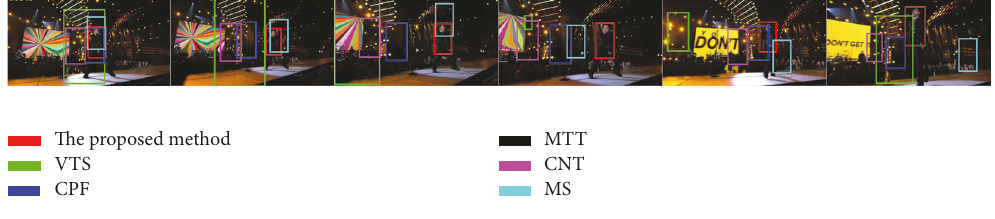
Figure 8: Qualitative evaluation about of the tracker over sequences singer2 seq.